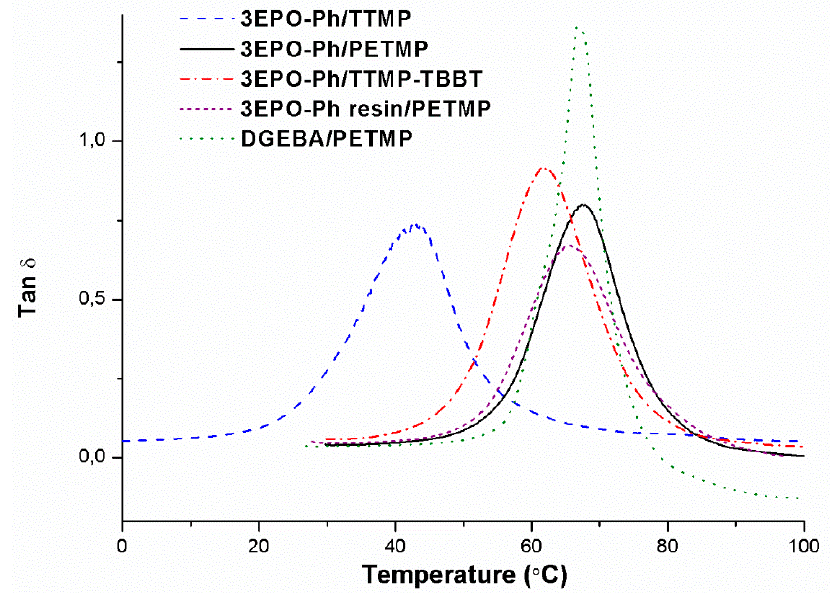
Figure 7. Plot of tan δ against temperature for the thermosets prepared.